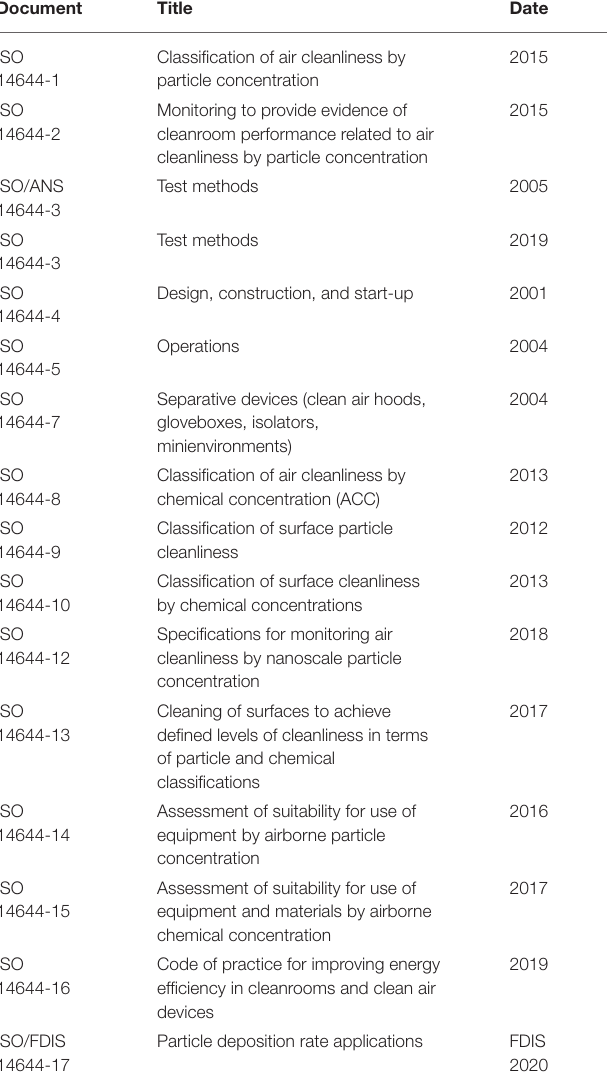
TABLE 5 | Standards for cleanroom manufacturing space control and monitoring 9